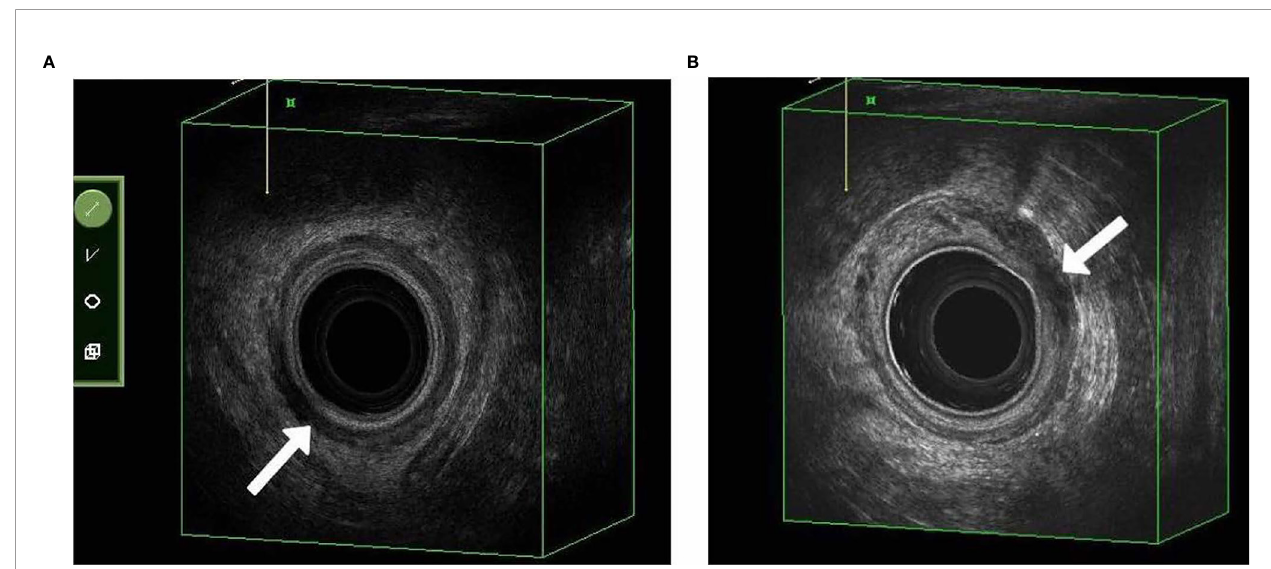
FIGURE 2 | 3D-TRUS pictures. (A) A case with complete response determined by three-dimensional transrectal ultrasound (3D-TRUS) and con fi rmed by TME pathological report (TRG = 0). (B) A case with tumor residue which was also con fi rmed by TME pathological report with TRG = 3.